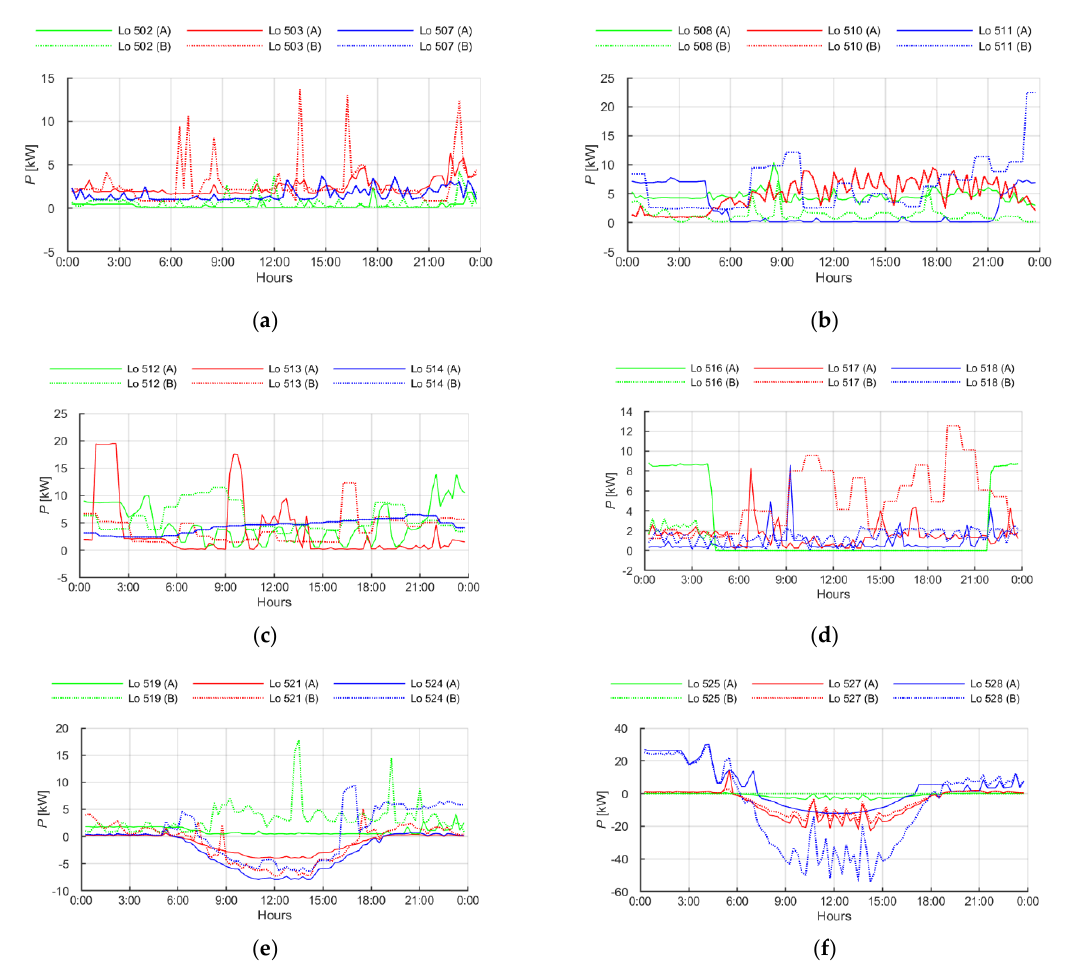
Figure 9. Daily variations of the power in the analyzed LV grid (without ESU); ( a ) nodes 502, 503, 507, ( b ) nodes 508, 510, 511, ( c ) nodes 512, 513, 514, ( d ) nodes 516, 517, 518, ( e ) nodes 519, 521, 524, ( f ) nodes 525, 527, 528; (A) — profile A, (B) — profile B.